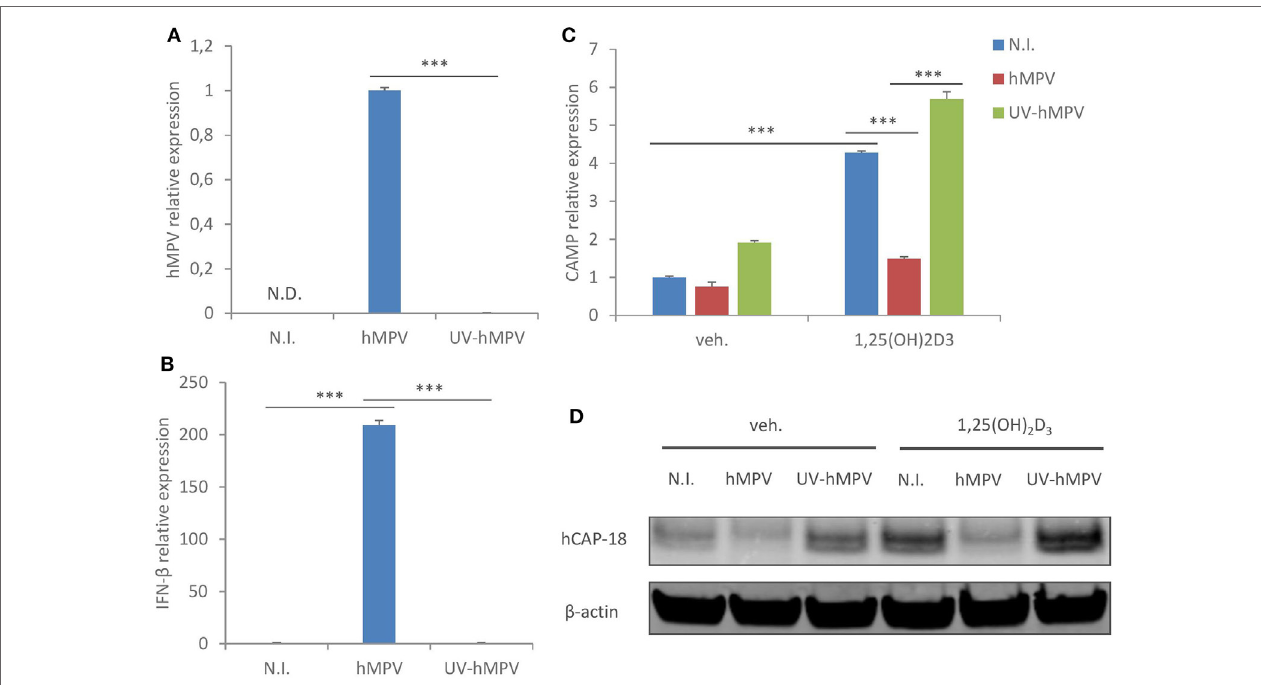
FigUre 2 | Human metapneumovirus (hMPV)­mediated suppression of cathelicidin antimicriobial peptide (CAMP) is dependent on viral replication. (a,B) Monocyte­derived macrophages (MDMs) were mock­infected (N.I.), infected with hMPV or inoculated with UV­irradiated hMPV (UV­hMPV) for 24 h. mRNA expression of hMPV N protein (hMPV) (a) or interferon­ β (IFN­ β ) (B) was assessed by quantitative real­time PCR (qRT­PCR). (c,D) MDMs were mock­infected (N.I.), infected with hMPV or inoculated with UV­irradiated hMPV (UV­hMPV) in the presence or absence of 1,25(OH) 2 D 3 for 24 h. CAMP mRNA expression (c) and protein expression (hCAP­18) (D) were assessed by qRT­PCR and immunoblotting. Error bars represent SD for triplicates. N.D., not detected. *** p < 0.001. Data are representative of at least three independent experiments from different donors. Full­length blots are presented in Figure S1 in Supplementary